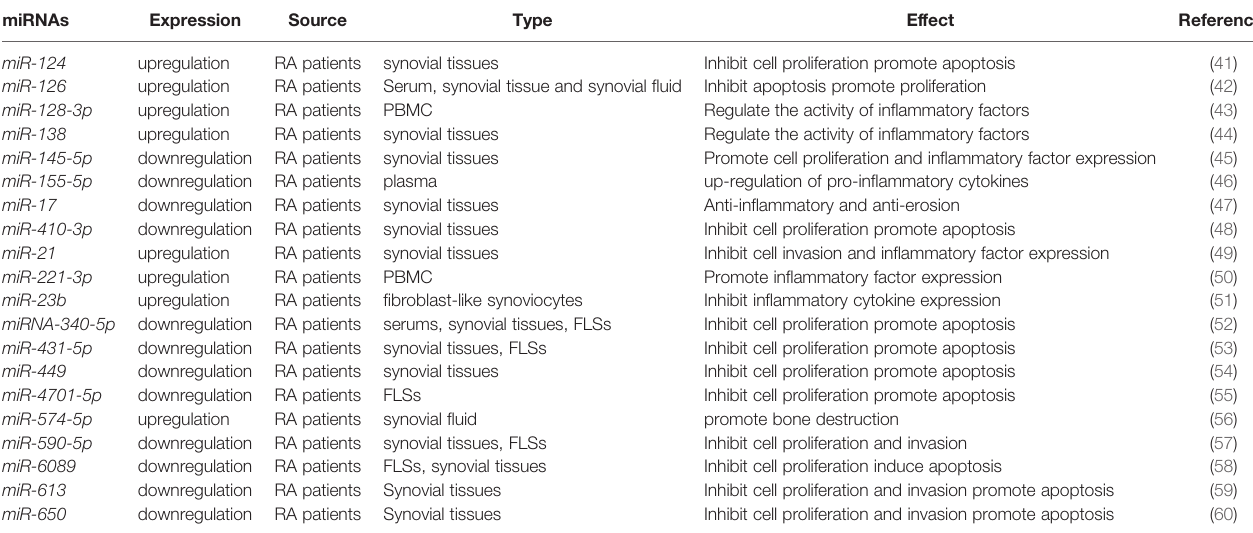
TABLE 1 | Representative miRNAs associated with RA pathogenesis and